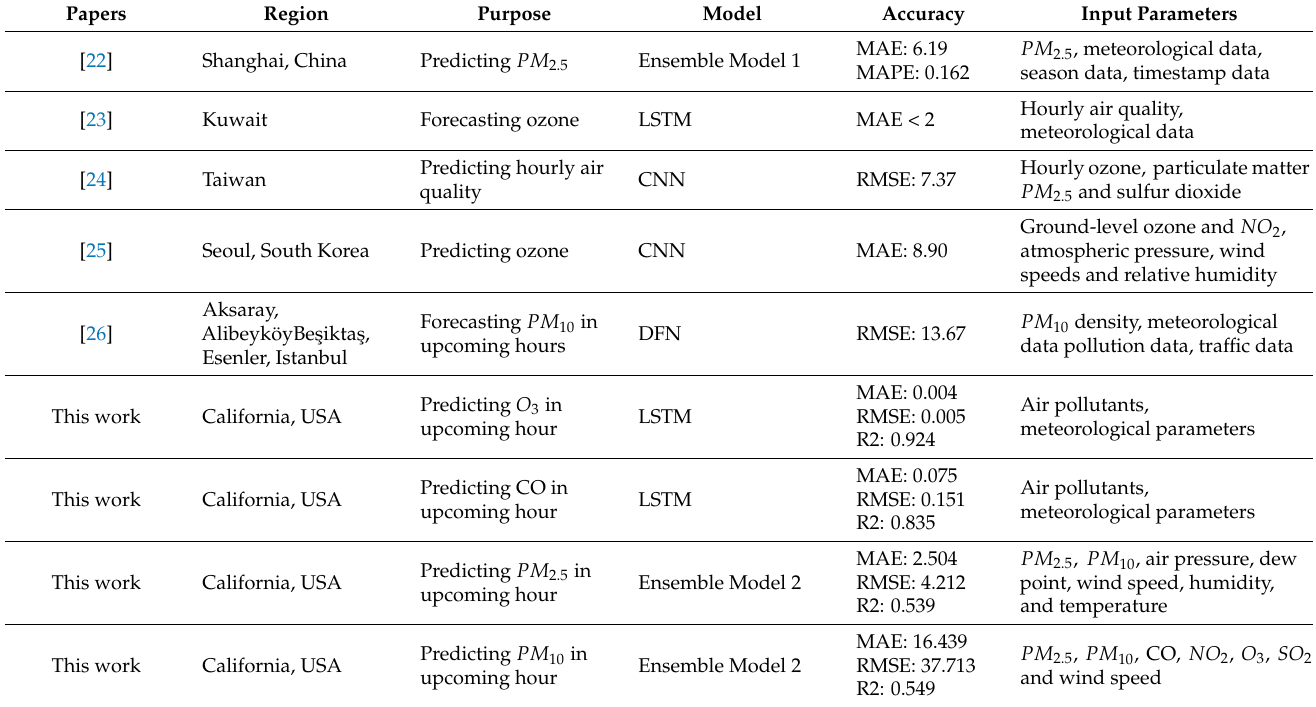
Table 8. Comparison of forecasting models of air pollutants (created by